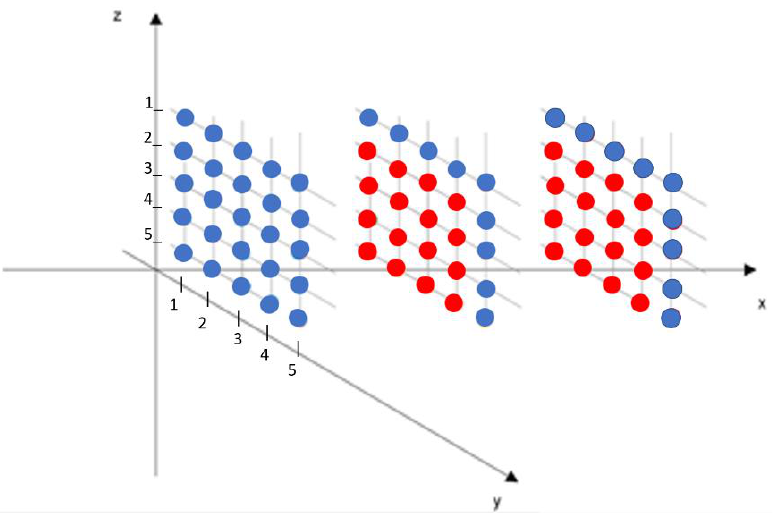
Figure 3. Subdivision of the fluid domain in 3 measuring grids of 25 points each with equal spacing steps Δ𝑥 = Δ𝑦 = Δ𝑧 = 5 cm . The colored blue points, different from the red ones, are considered boundary points for the numerical integration of the continuity equation.